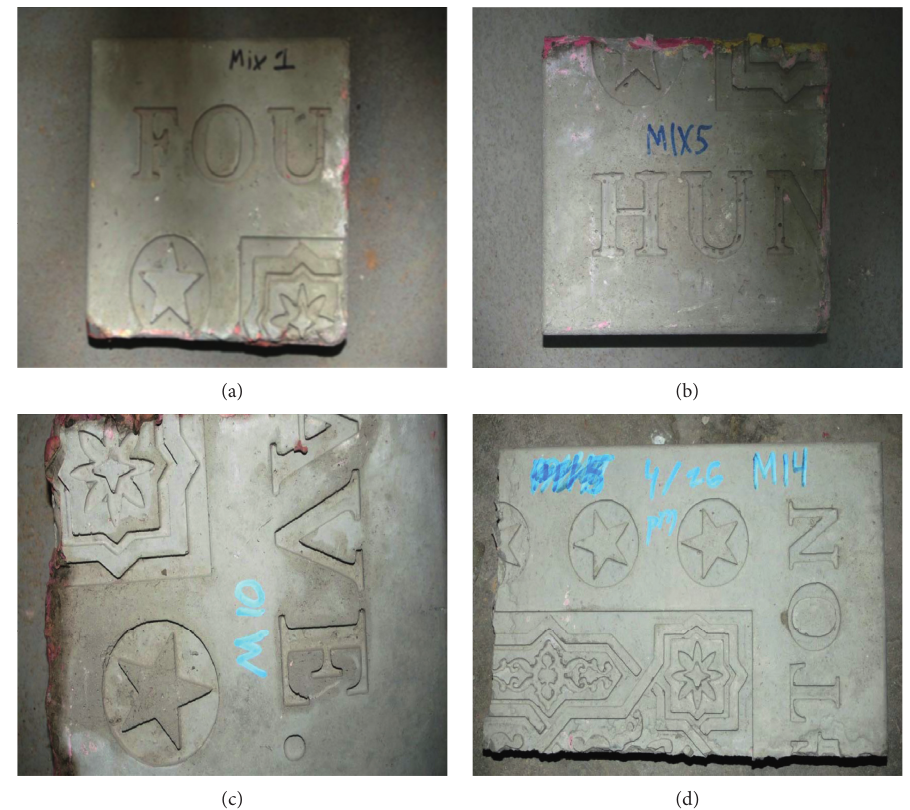
Figure 2: Impression result of samples from different batches. (a) Batch 1. (b) Batch 5. (c) Batch 10. (d) Batch